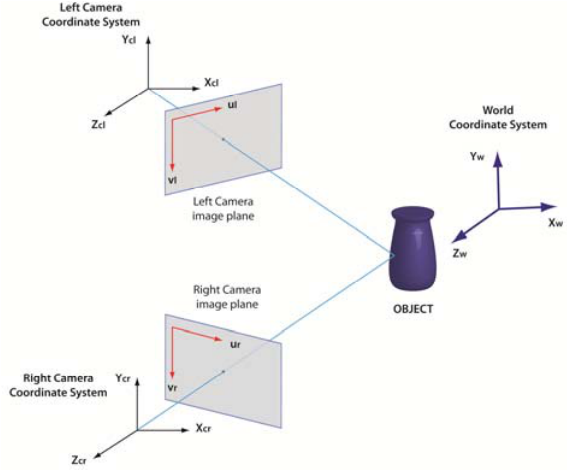
Figure 3. Coordinate systems of the cameras and the